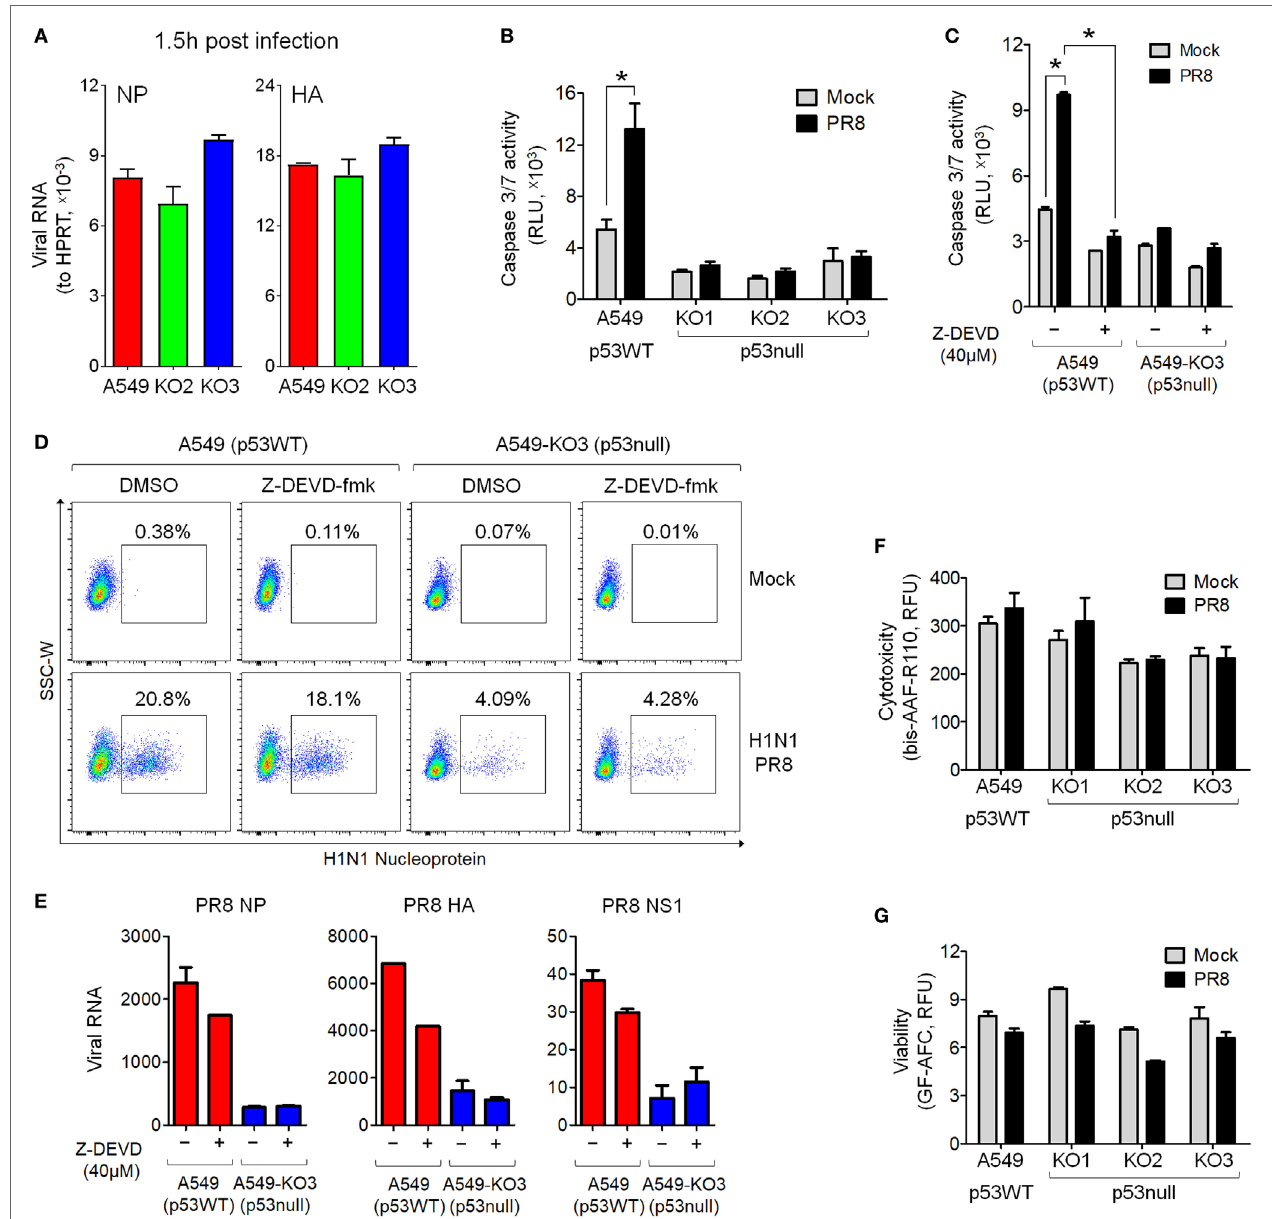
FigUre 3 | Decreased IAV susceptibility is not mediated by blocked cell entry at the initial stage of infection or decreased caspase 3 activation in p53null cells. (a) Real-time quantitative PCR (RT-qPCR) of viral RNA detected in IAV-infected A549, A549-KO2, and A549-KO3 cells at 1.5 h post-infection [multiplicity of infection (MOI) = 0.001]. (B) Caspase 3/7 activity in mock- or IAV-infected A549 and p53null cells. * p < 0.05. (c) Caspase 3/7 activity in mock- or IAV-infected A549 and A549-KO3 cells in the presence ( + ) or absence ( − ) of the caspase 3-specific inhibitor Z-DEVD-fmk (40 µM). * p < 0.05. (D) Flow cytometry analysis of IAV nucleoprotein (NP) expression in mock- or IAV-infected A549 and A549-KO3 cells, in the presence ( + ) or absence ( − ) of the caspase 3-specific inhibitor Z-DEVD- fmk. (e) RT-qPCR of viral RNA in the culture supernatant of IAV-infected A549 and A549-KO3 cells, in the presence ( + ) or absence ( − ) of the caspase 3-specific inhibitor Z-DEVD-fmk. (F) Cellular cytotoxicity in mock- and IAV-infected p53WT and p53null A549 cells. (g) Cell viability in mock- and IAV-infected p53WT and p53null A549 cells. For panels (B–g) , all measurements were performed at 24 h post-IAV infection (MOI =